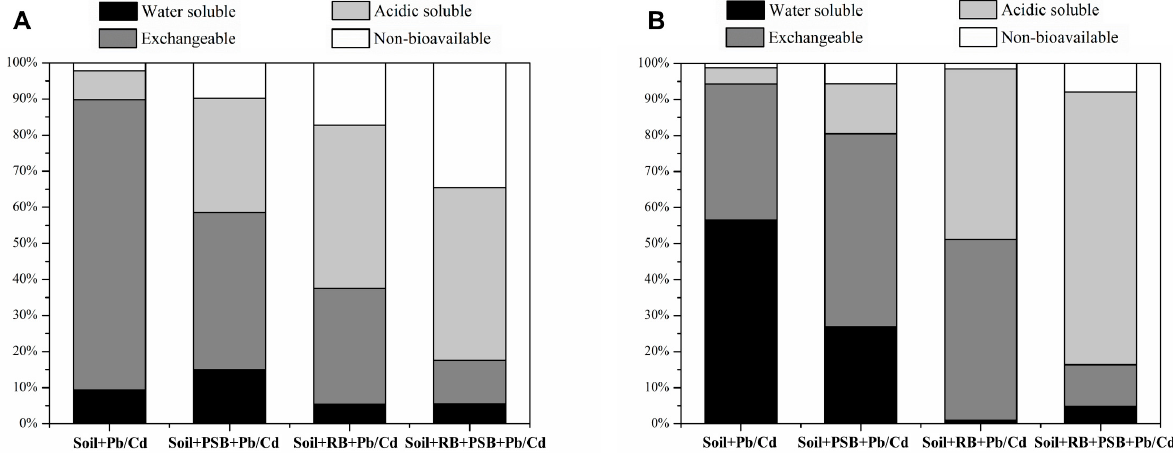
Figure 3. Speciation of toxic heavy metals Pb ( A ) and Cd ( B ) in soils (RB—rice husk biochar, PSB— Enterobacter sp.).